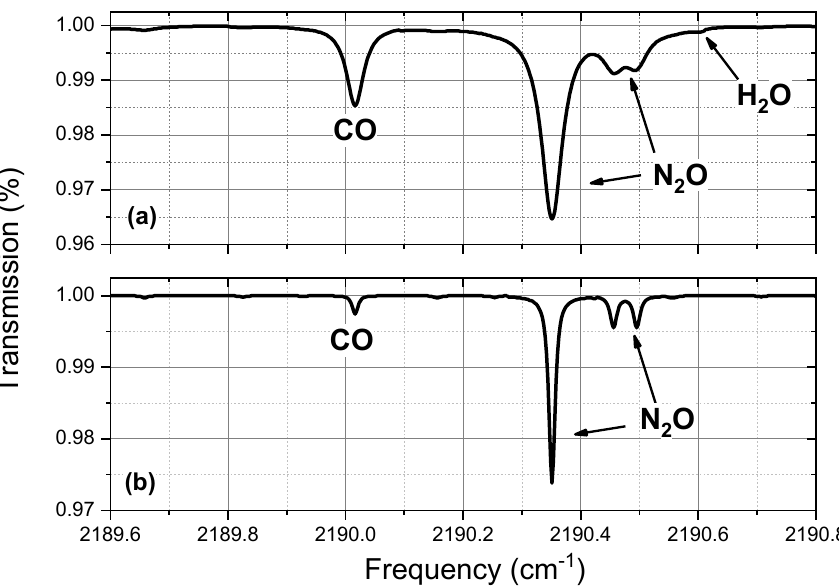
Figure 1. HITRAN simulation of the spectral region around the selected CO line. ( a ) Simulation of the tropospheric spectrum at 300 mbar (about 10 km altitude). The CO mixing ratio is 100 ppbV, the N 2 O mixing ratio is 325 ppbV and we overestimated the water vapour mixing ratio to 1000 ppmV. ( b ) Simulation of the stratospheric spectrum at 80 mbar (about 20 km altitude). The CO mixing ratio is 20 ppbV, the N 2 O mixing ratio is 260 ppbV and the water vapour (not visible) mixing ratio is 10